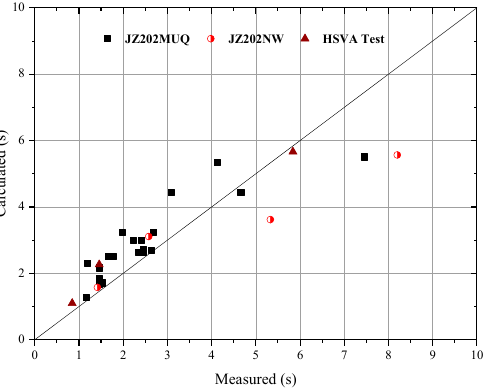
Based on the ice thickness and ice speed data obtained from field measurements, the ice force cycle was calculated by using the above-described average ice force period relationship, and the measured ice force cycle was compared and analyzed (Figure 12). The overall calculated average period was slightly longer than the measured ice force period. Sea ice inhomogeneity and secondary fractures cause the extracted ice force cycle to be shorter. The measured ice force cycle was based on pressure box data analysis, and the ice thickness and ice velocity were obtained from ice-image cameras. During the climbing process of sea ice interacting on the conical structure, secondary fractures may occur. The period of secondary fracture is less than the primary failure period of sea ice. The period measured by the ice load measured panel includes the period of secondary fracture. Then, compared with the structural response caused by the primary fracture of sea ice, the structural response caused by the secondary fracture of sea ice climbing is small, and the fatigue damage to the structure is also small. The above expression was used to calculate the average ice force cycle to meet engineering needs.